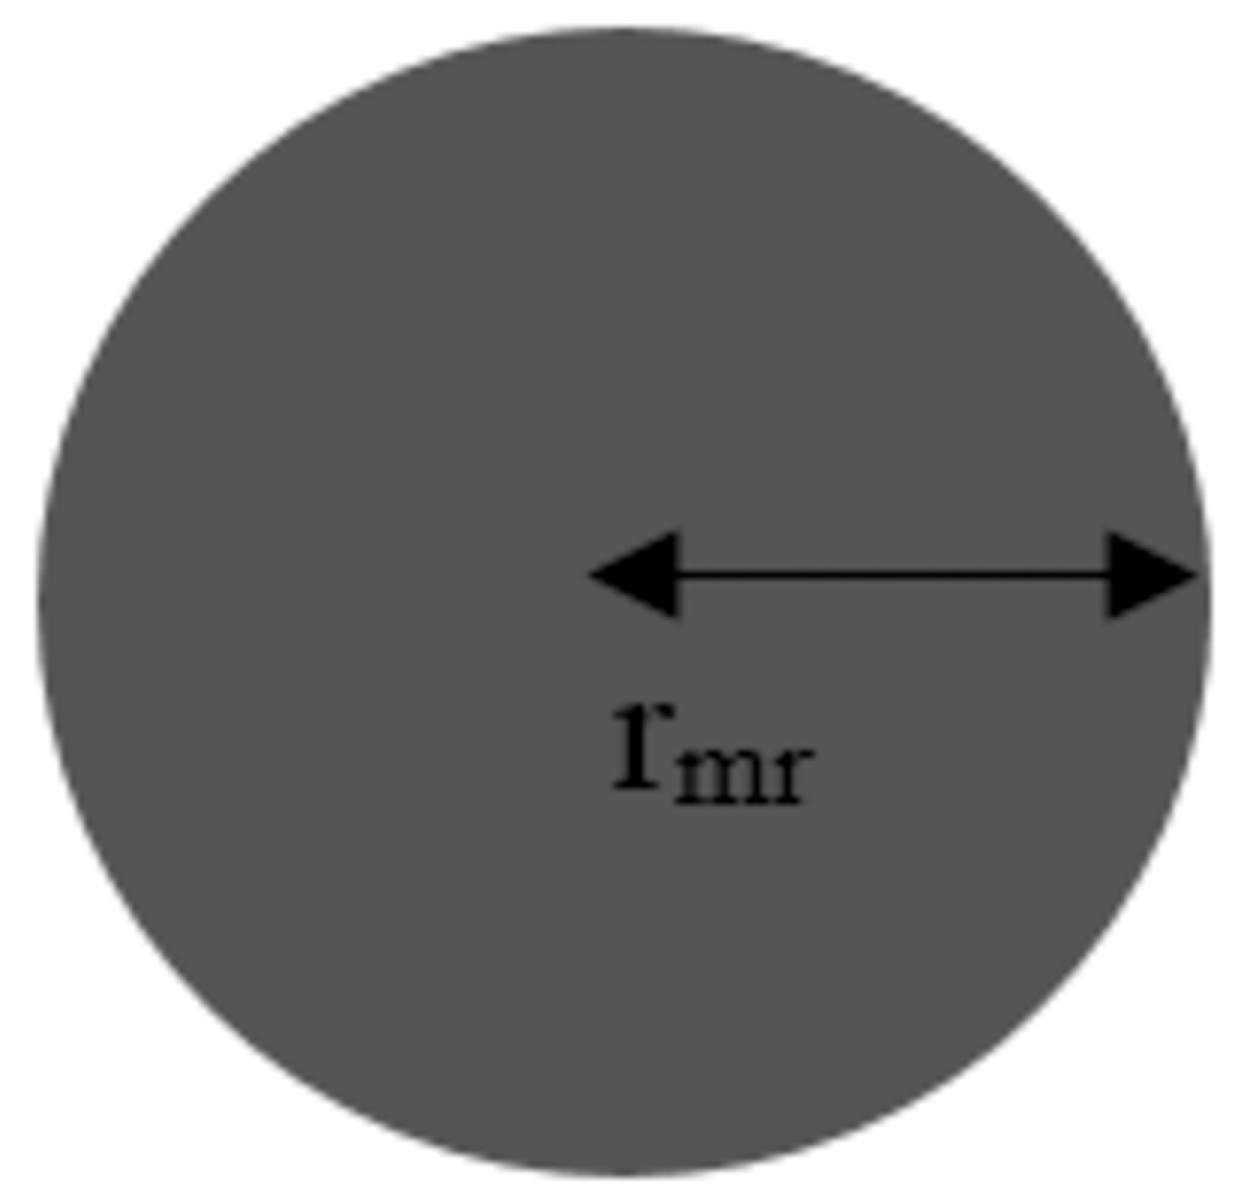
Fig 2. Characteristics of